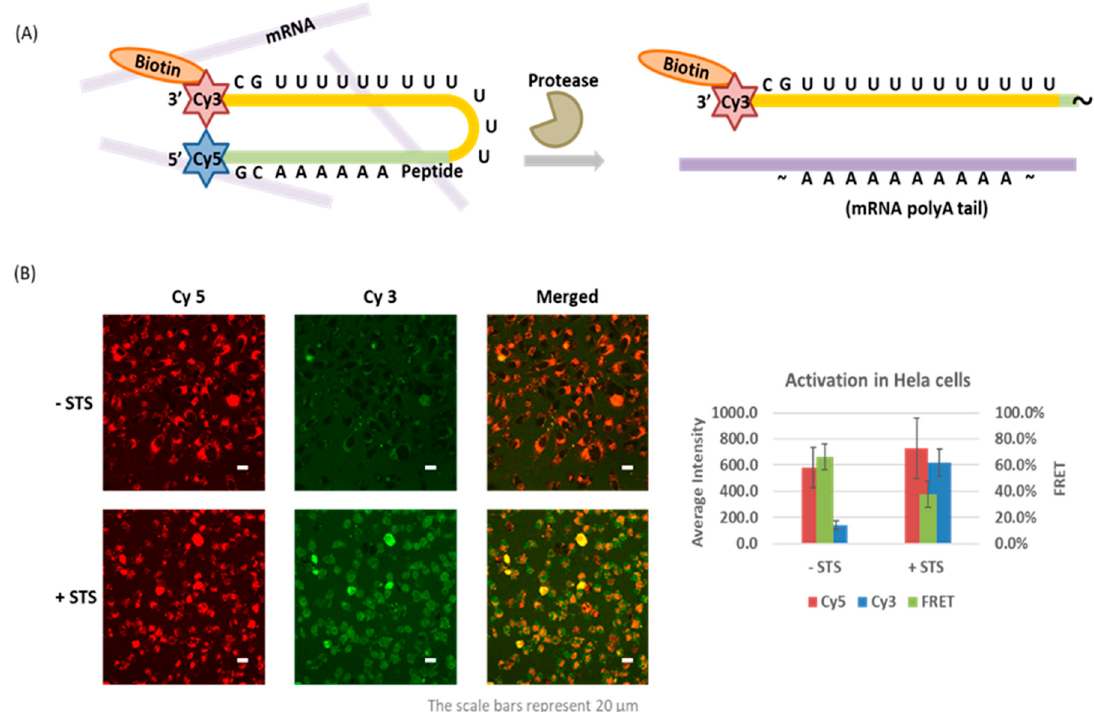
Figure 4. Protease-activated oligo probe: ( A ) Caged probe features a hairpin structure including peptide linker, FRET pair and biotin handle. Caspase-3 cleaves the peptide substrate, promotes release of capture strand (yellow) and binding of mRNA target (purple); ( B ) Confocal fluorescence micrographs and quantification of caged probe remaining high FRET (high intensity of Cy5 fluorescence) in control sample and low FRET (high intensity of Cy3 fluorescence) in apoptotic cells, 8 h after staurosporine treatment. Adapted from ref [92]. The figure is adapted with permission from Yang, L. et al. Bioconjug. Chem. 2020, 31, 9, 2172–2178. Copyright (2020) American Chemical